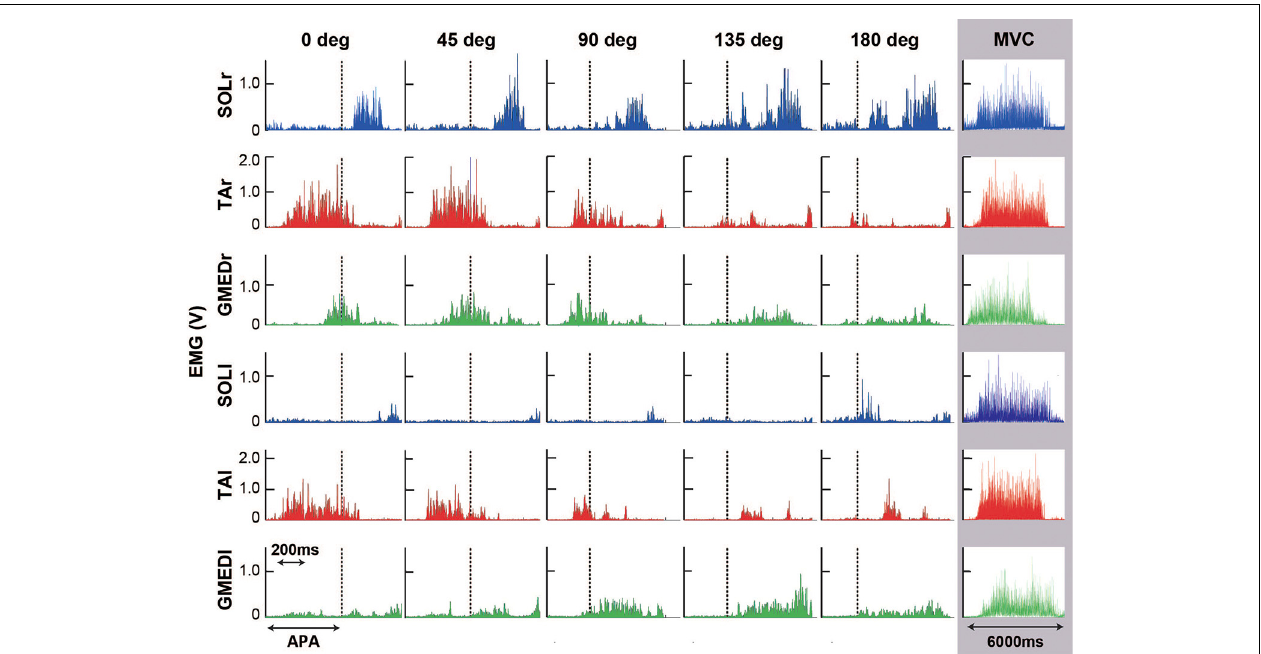
FIGURE 5 | Typical example of rectified electromyographic (EMG) activities of the soleus (SOL; blue), tibialis anterior (TA; red), and gluteus medius (GMED; green) of stance foot side (r) and stepping foot side (l) during steps to 0, 45, 90, 135, and 180 degrees and maximal voluntary contraction (MVC) trial. Dash lines for each figure show the end of the anticipatory postural adjustment (APA) phase. Note that the scale of the horizontal axis (time) is different between the stepping trials (five figures from the left) and the MVC trial (rightmost row) since the difference in movement duration was